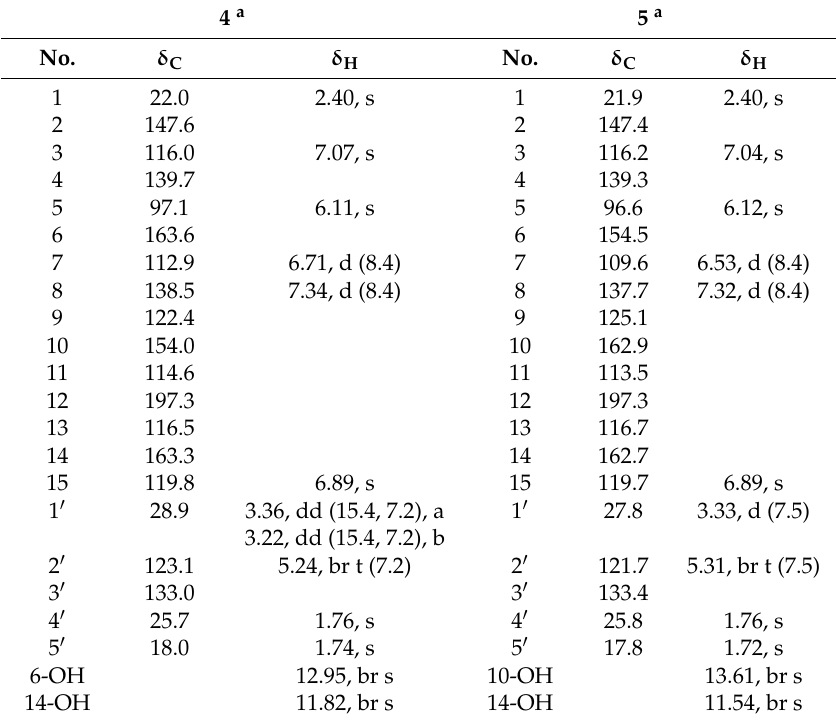
Table 2. The 1 H-NMR and 13 C-NMR data of 4 and 5 ( δ in ppm, J in Hz).